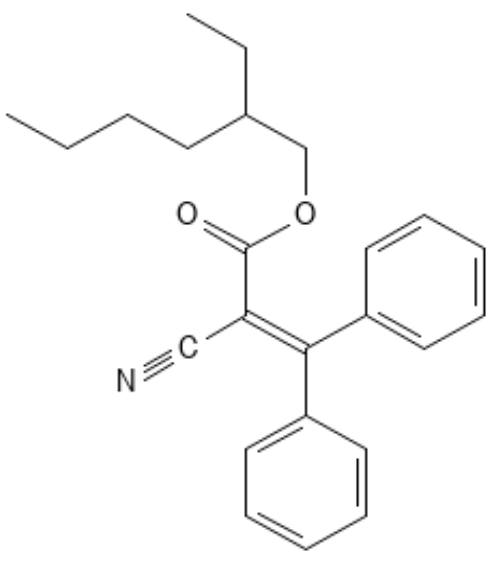
Figure 4. GC/MS absorption spectra of SF-10.